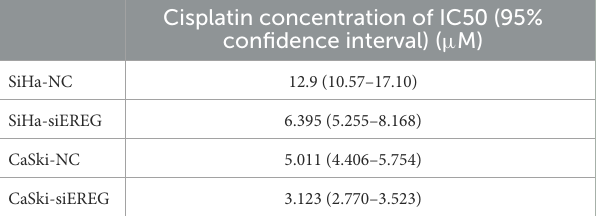
TABLE 1 The four-parameter logistic equation of GraphPad Prism was used to determine the IC50 of cisplatin for each type of cervical cancer cell, taking into account their divergent EREG